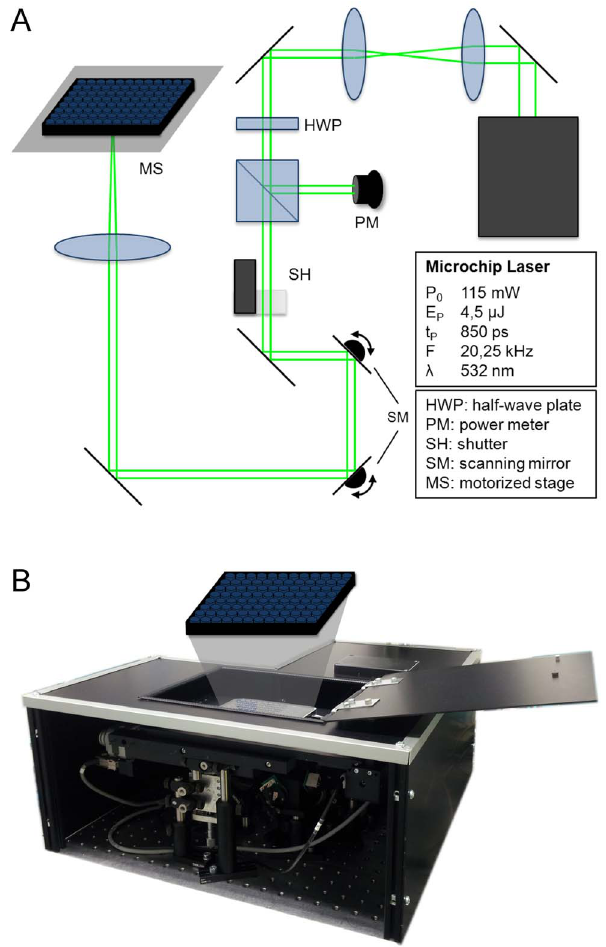
Figure 1. Experimental setup. A: Schematic drawing and B: photograph of the